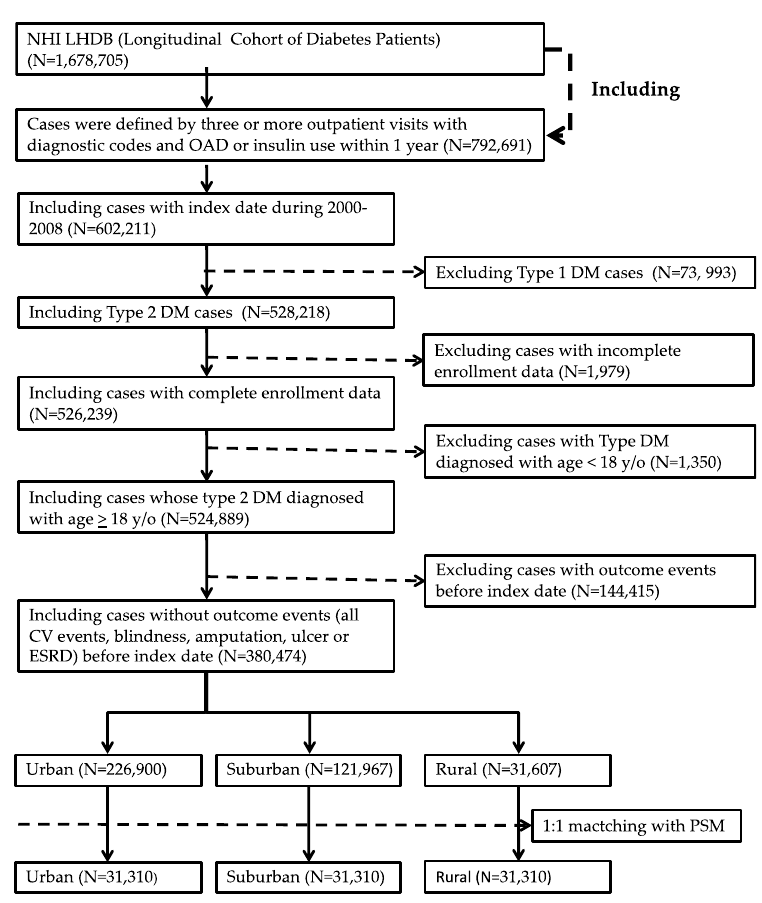
Figure 1. Flow chart of the screening and inclusion of study